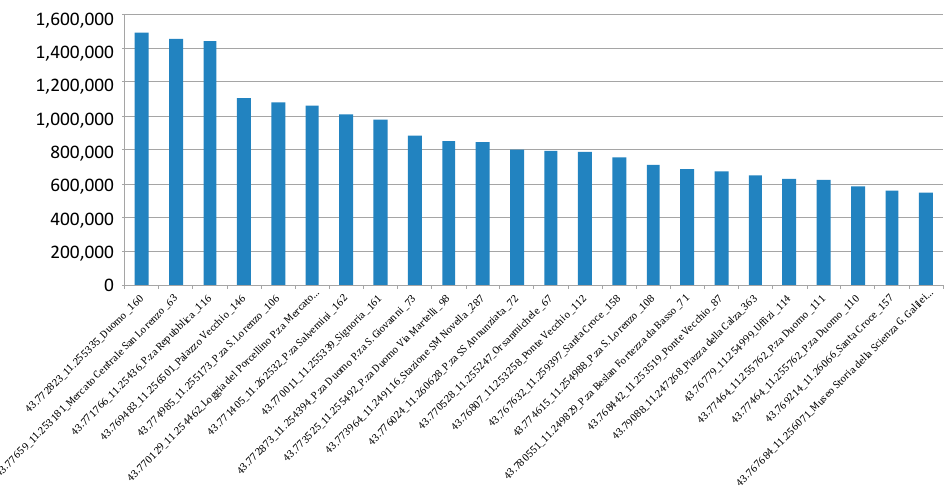
Figure 8. Distribution of hottest places in Florence (truncated series). The chart shows the cumulated number of Wi-Fi accesses in last 180 days ( y -axis) associated to a lat/long of the access points distributed in the city ( x -axis).